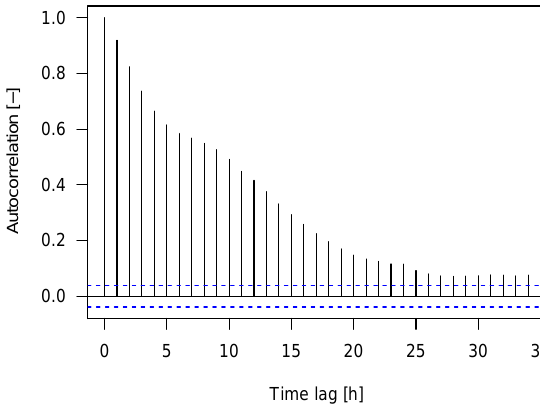
Figure 11. WRF forecasted snowmelt autocorrelation at the catchment outlet calculated for the calibration and validation period. Horizontal blue lines indicate the autocorrelation significance bounds.